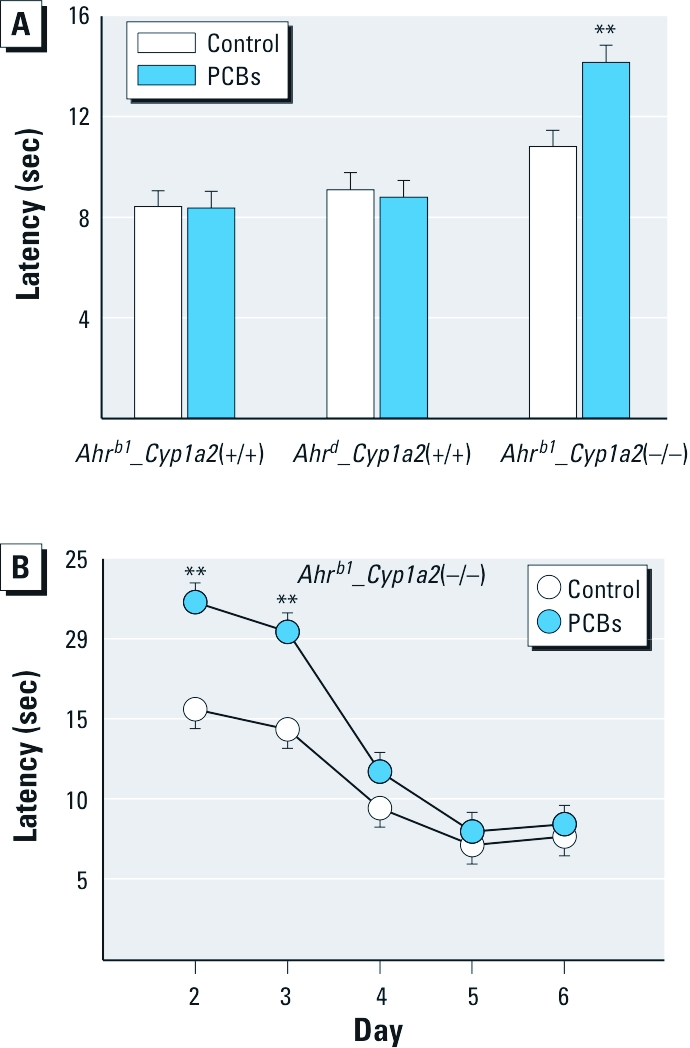
Results of the MWM (cued) test (mean ± SE). (A) Latency to reach goal. (B) Latency in the Ahrb1_Cyp1a2(–/–) group on days 2–6 (two trials per day). No differences were seen on day 1 (data not shown). **p < 0.01 compared with untreated control.